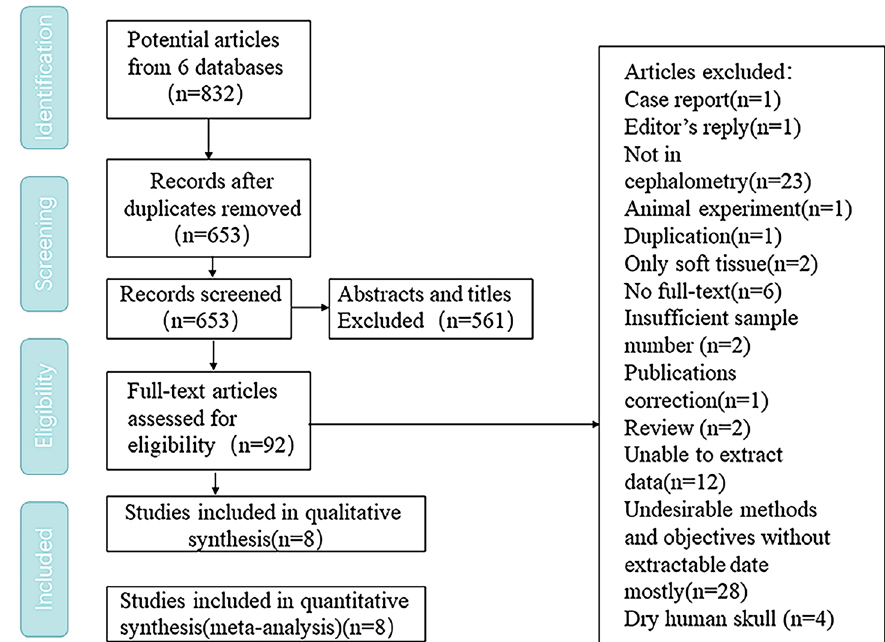
Figure 1. Study flow